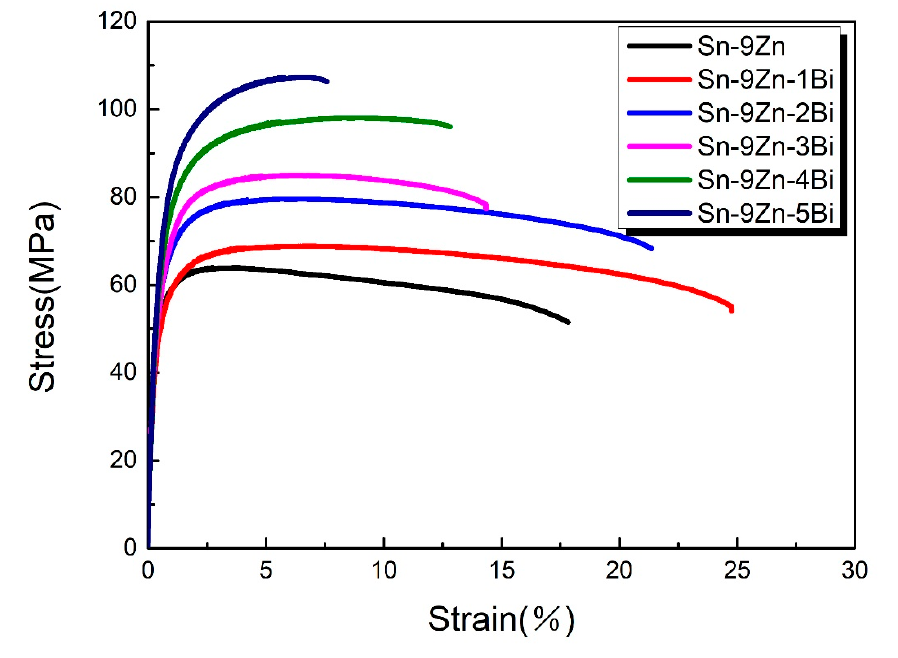
Figure 9. Engineering stress–strain curves of Sn-9Zn-xBi alloys. Table 3. Tensile strength and elongation of Sn-9Zn-xBi alloys.